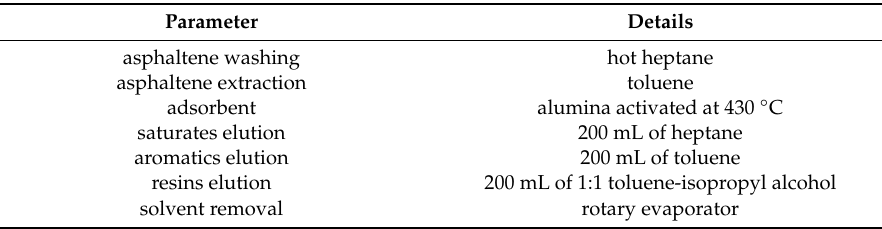
Table 4. Molar fractions (%) of primary (C p ), secondary and quaternary (C sq ), tertiary (C t ), aromatic (C ar ) groups, aromaticity factor (F CA ), and mean chain length (MCL) of aliphatic hydrocarbons based on 13 C NMR spectra of samples 1–4. Sample Number